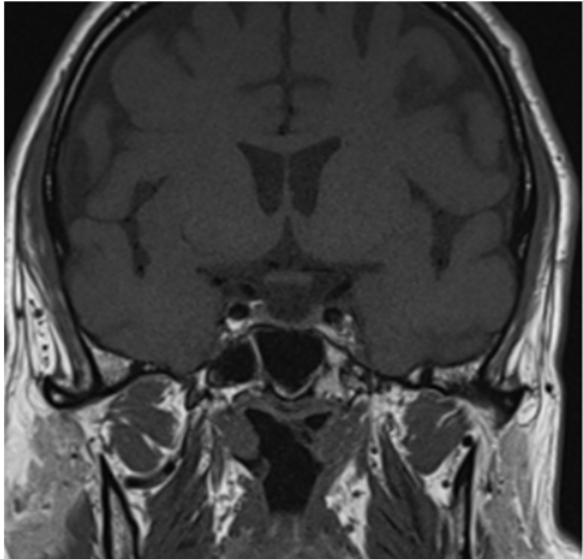
Figure 1. Partial “empty sellae syndrome” on brain MRI sagittal section. Pituitary gland reduced in size and lying along the floor of sphenoid sellae.